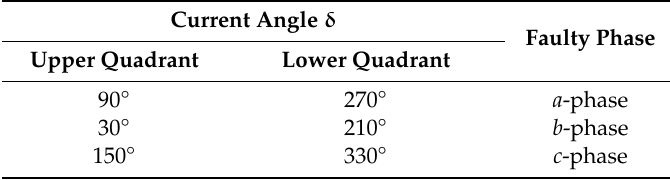
Figure 2. Output current vector of a -phase fault: ( a ) three-phase winding; ( b ) current vector. Table 1. Current angle at di ff erent faulty